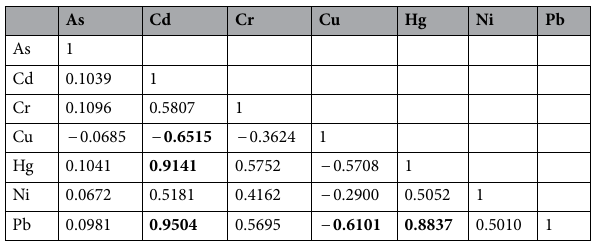
Table 4. Pearson correlations of the heavy metal pollutants in the meat samples. Significant values are in [bold].